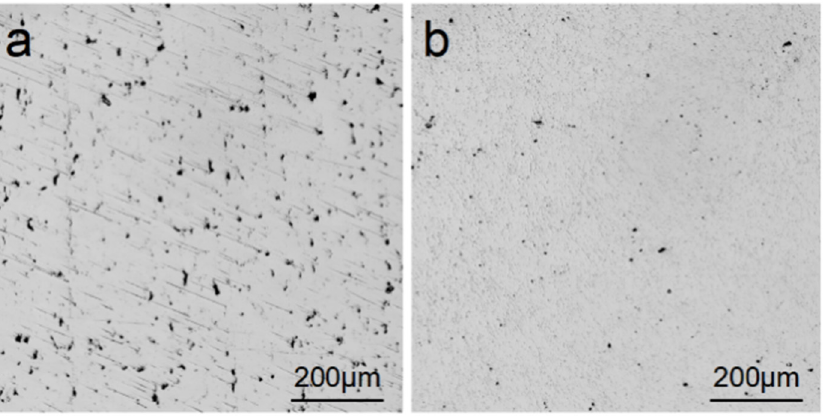
Figure 3. Metallographic microstructure of Ti-30Mo-nTiC alloys: ( a ) Ti-30Mo, ( b ) Ti-30Mo-0.5TiC.